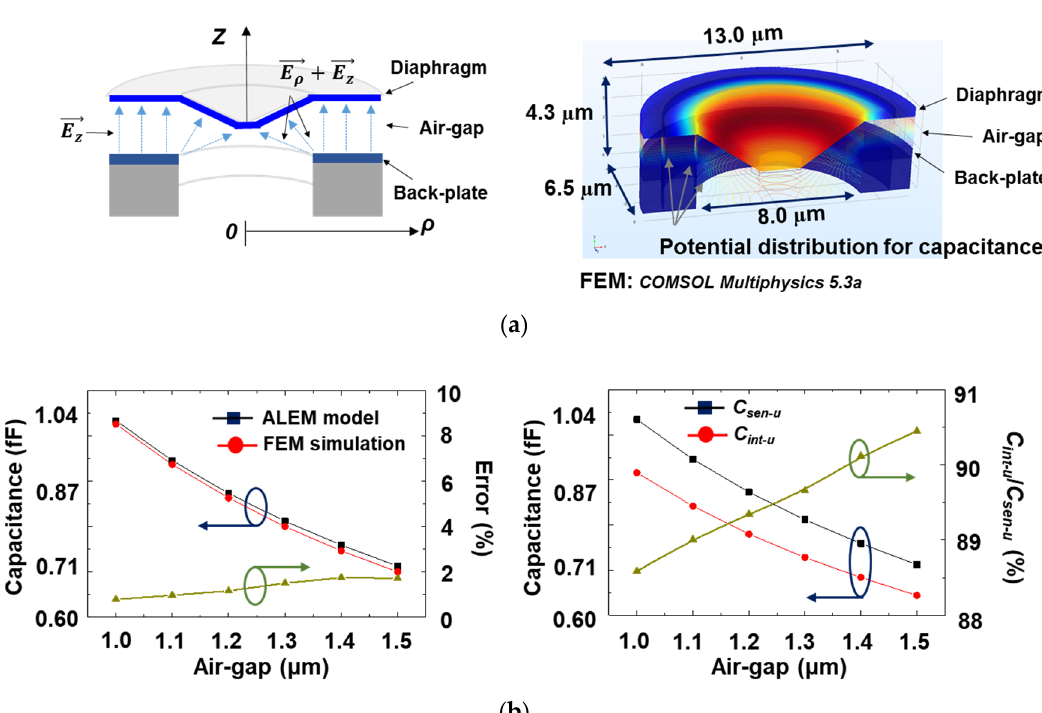
Figure 4. ( a ) Electric field distribution concept diagram of the inner part composing a unit cell and potential distribution by FEM simulation; ( b ) ALEM model and FEM simulation result and error result for the air gap-capacitance relation, and the total and the intrinsic capacitance for the air gap–capacitance relationship and its attenuation coefficient results.